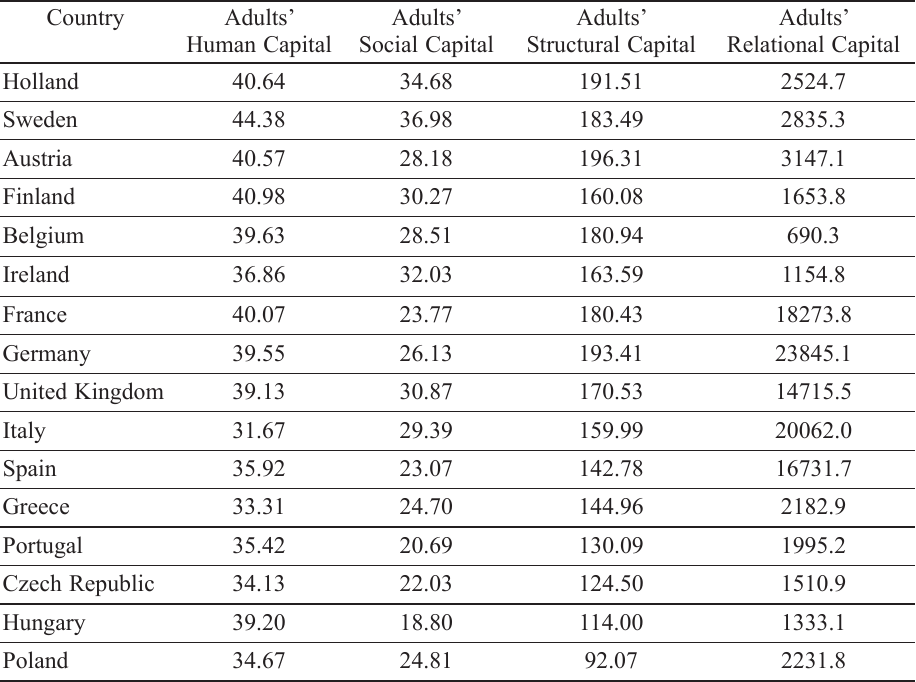
Table 4. Human, social, structural and relational capital of adults in particular countries Country Adults’ Adults’ Adults’ Human Capital Social Capital Structural Capital